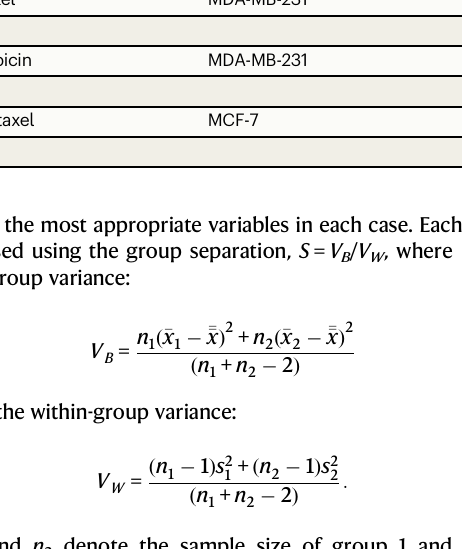
Table 3 | The three data sets used in this study with the number of cells in training and test sets used for untreated vs treated classi fi cation Data